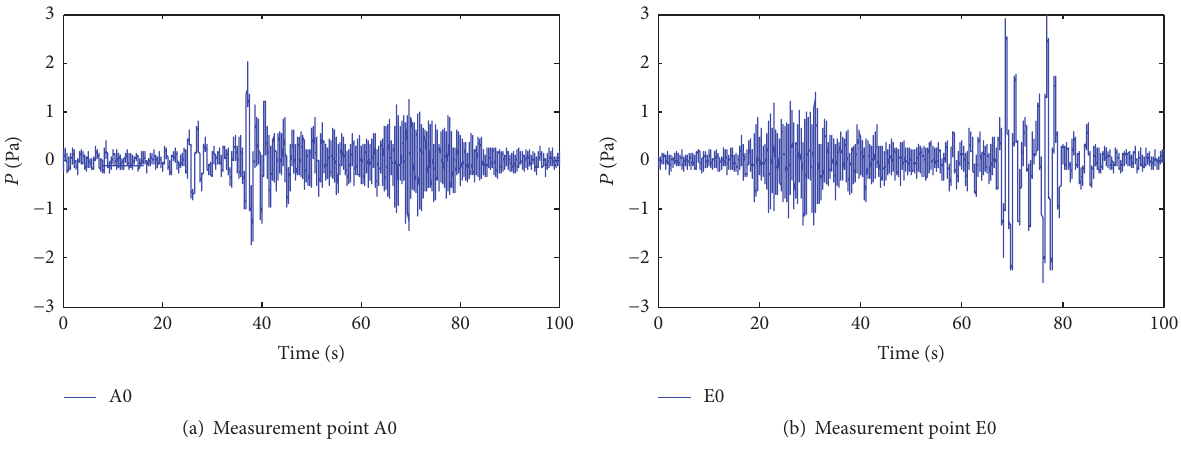
Figure 5: Ambient noise time history of sampled measurement points.